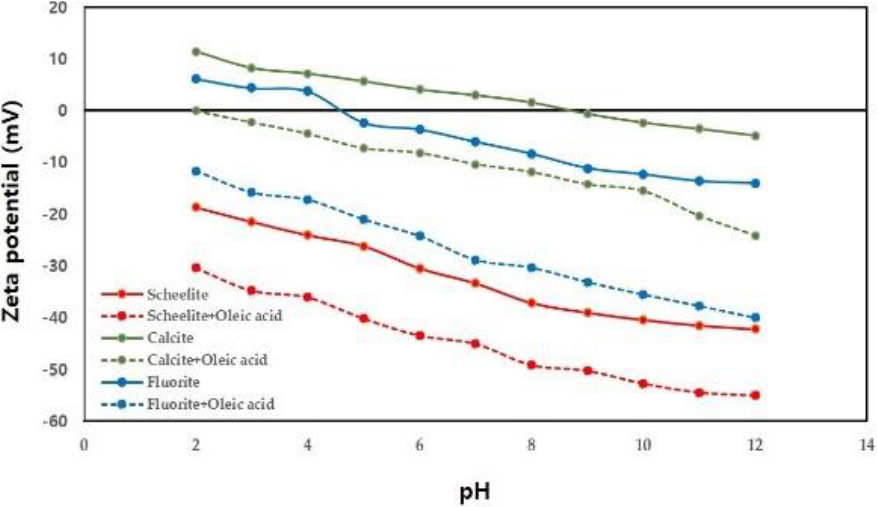
Figure 2. Zeta potentials of scheelite, calcite and fluorite in the absence and presence of oleic acid as a collector .